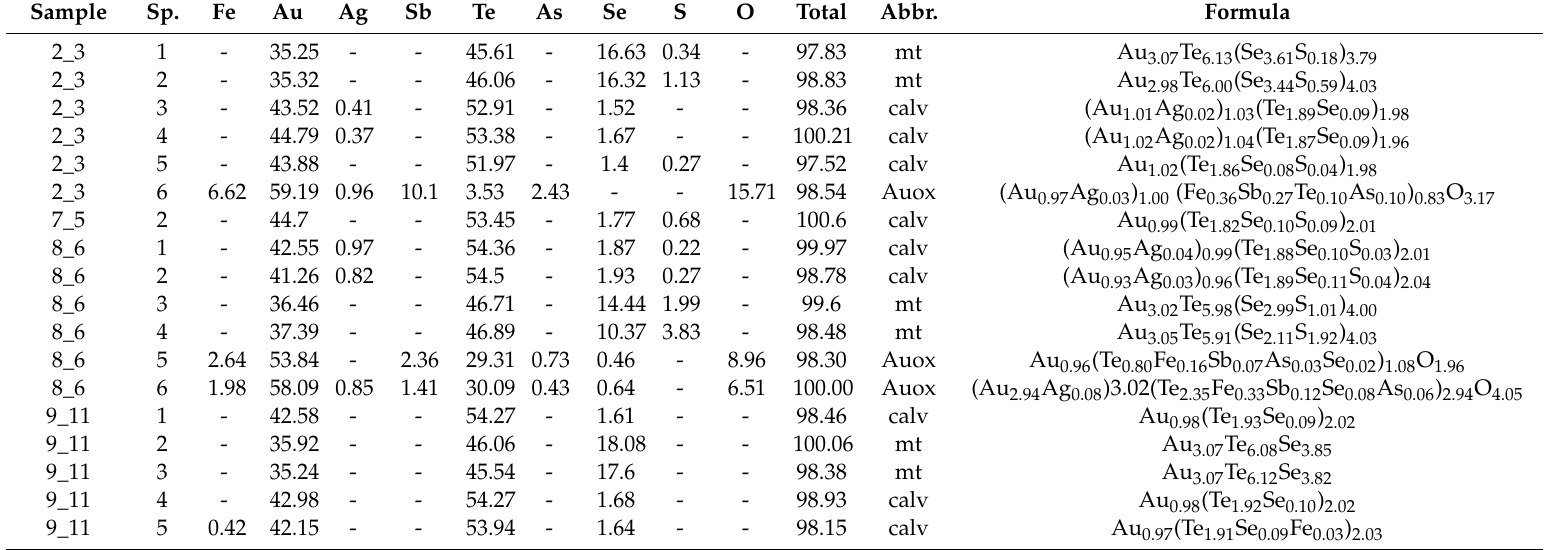
Table 6. Composition of calaverite grains, products of its replacement (mustard gold and Fe antimonate / tellurate) and associated minerals (maletoyvayamite) (wt. %) shown in Figure